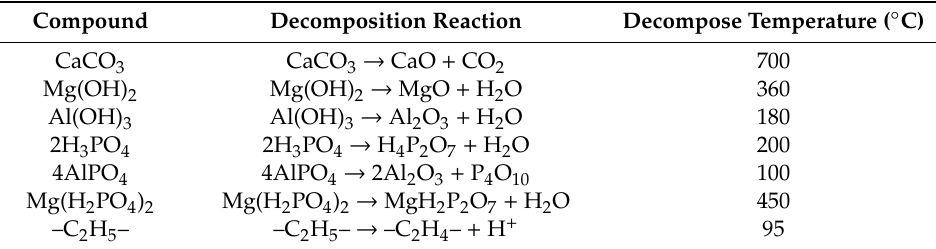
Table 3. Potential compound present in BAIC samples, decomposition reaction and temperature. Compound Decomposition Reaction